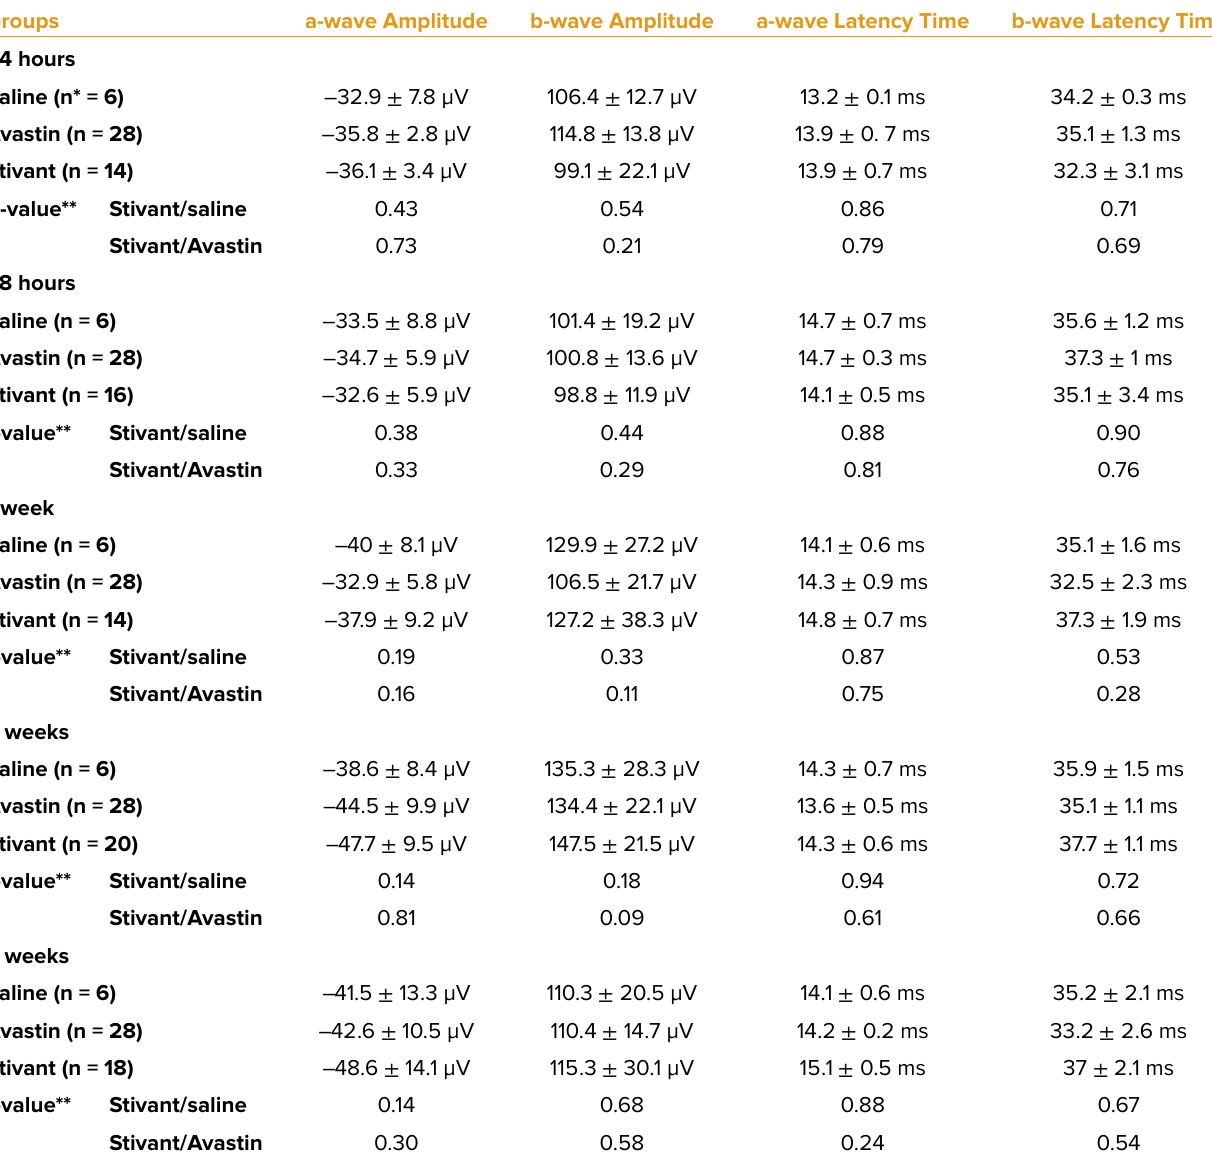
Table 5. Comparison of the amplitudes and latency times of rod responses from the Stivant-treated rabbits, saline-treated rabbits, and Avastin-treated rabbits